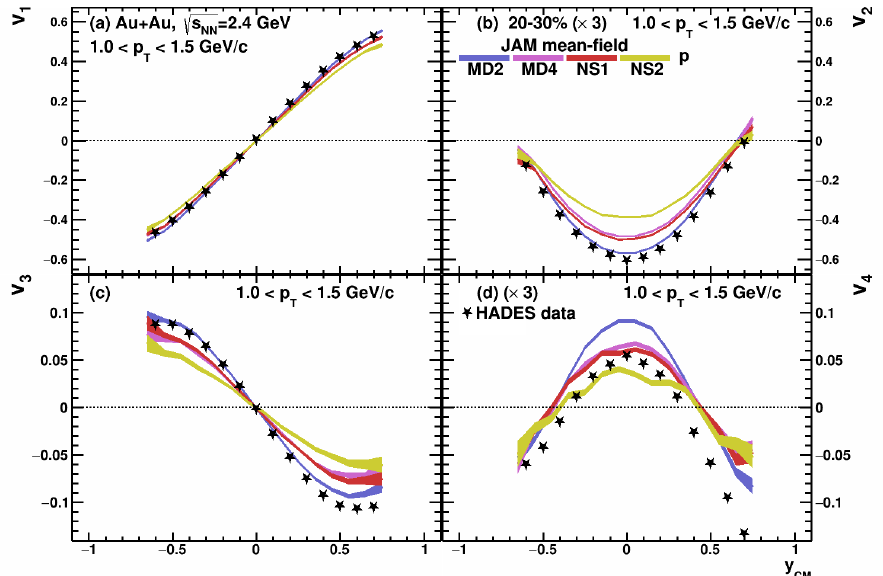
Figure 7. Rapidity ( y cm ) dependence of anisotropic flow coefficients v 1 , v 2 , v 3 and v 4 of protons ( a – d ) √ s NN = 2.4 GeV. The black closed symbols denote the in the 20–30% central Au + Au collisions at published data from the HADES experiment [17]. The blue (MD2), purple (MD4), red (NS1) and yellow (NS2) bands represent the results from the mean-field mode of the JAM model with different EOS, as indicated. The uncertainties of the simulated model data are statistical.